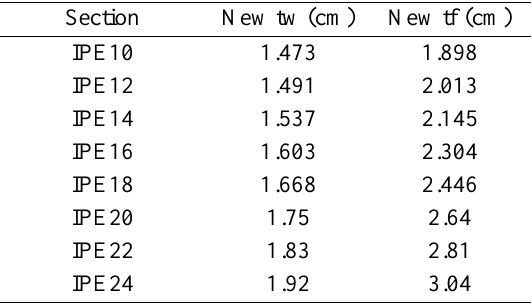
Table. 2. New size for thickness of the flange and web of the knee elements made of